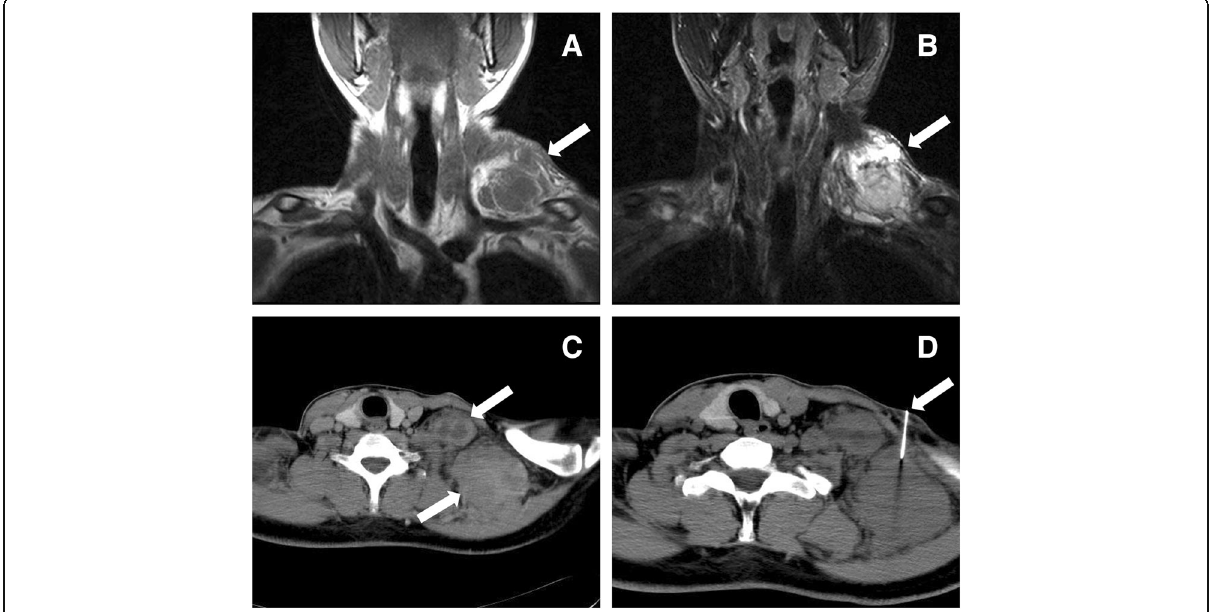
Fig. 1 T1-weighted images ( a ) and T2-weighted coronal images ( b ) on MRI show a soft tissue mass with inhomogeneous densities and fine separations in the left supraclavicular fossa (arrows). Axial CT scan ( c ) reveals a fused multinodular mass (arrows) with local necrosis; CT-guided core needle biopsy was then performed ( d